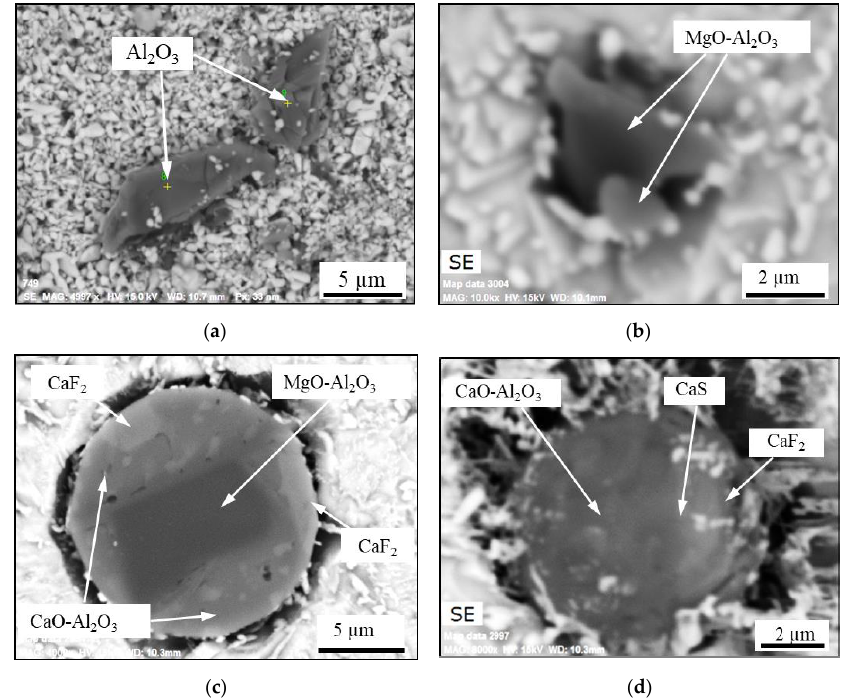
Figure 6. Typical oxide inclusions in different samples observed by three-dimensional (3-D) investigations on surfaces of steel samples after electrolytic extraction; ( a ) Type A: Al 2 O 3 ; ( b ) Type AM: Al 2 O 3 -MgO; ( c ) Type ACM: Al 2 O 3 -MgO + CaO-Al 2 O 3 + CaF 2 ; ( d ) Type AC: CaO-Al 2 O 3 + (CaF 2 +